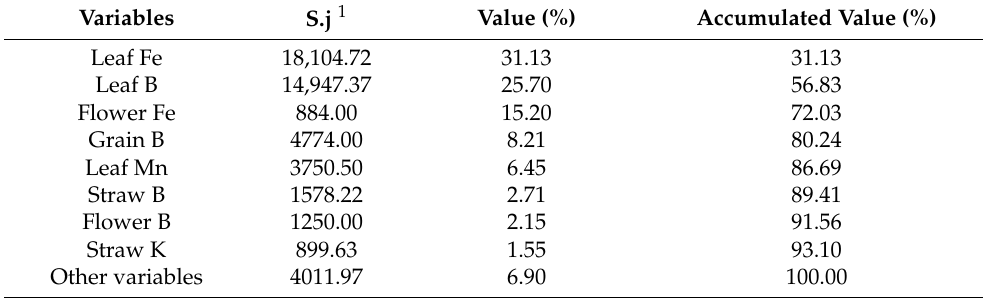
Table 6. Relative contribution of nutrient concentration in flowers, grains, straw, and leaves to genetic diversity in 9 genotypes of Coffea canephora , according to Singh’s (1981) method, Euclidean distance.